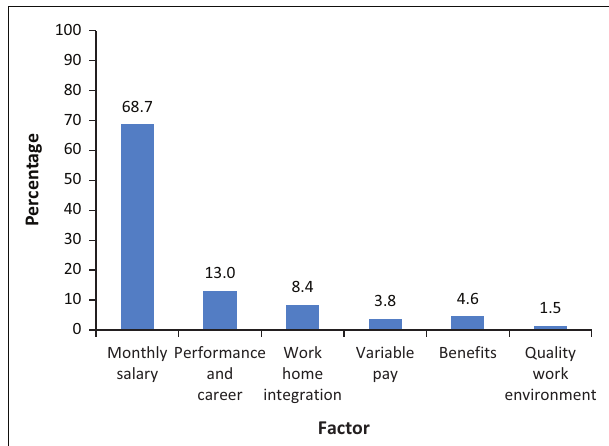
FIGURE 1: Ranking of factors which promote employee attraction.